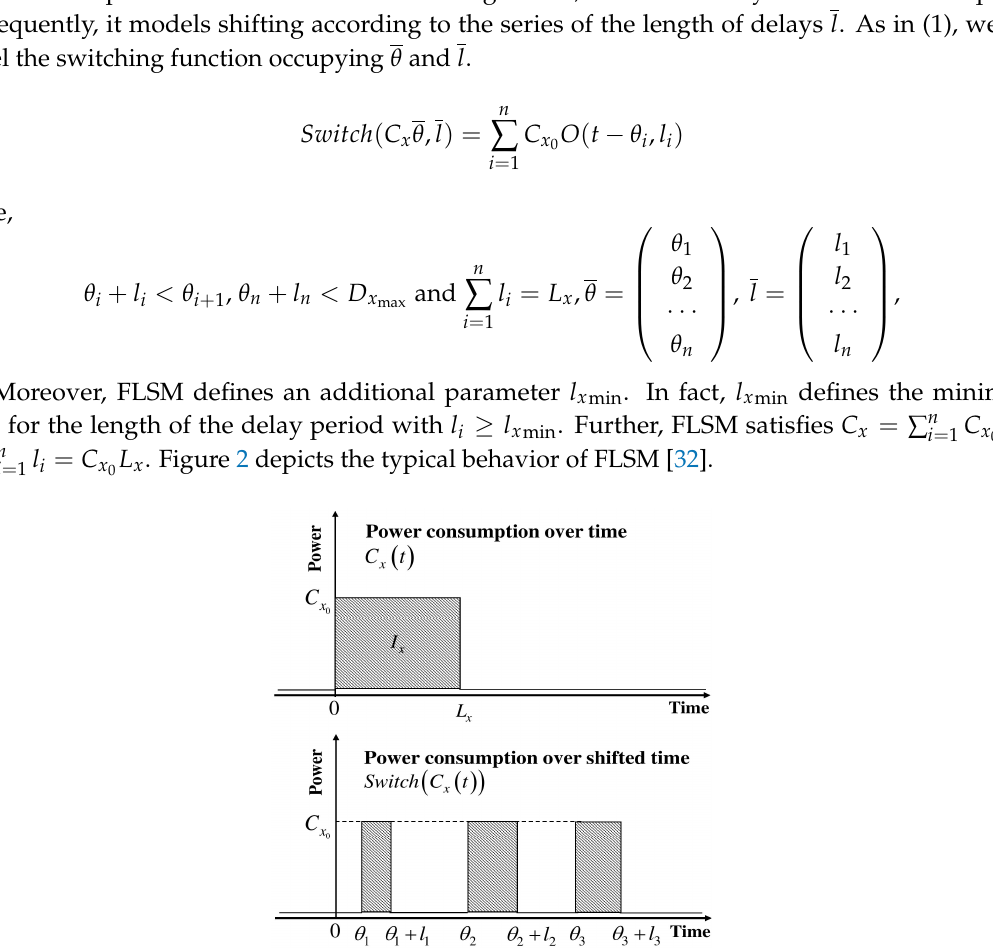
Figure 2. Shifting behavior of the flexible load shift model.